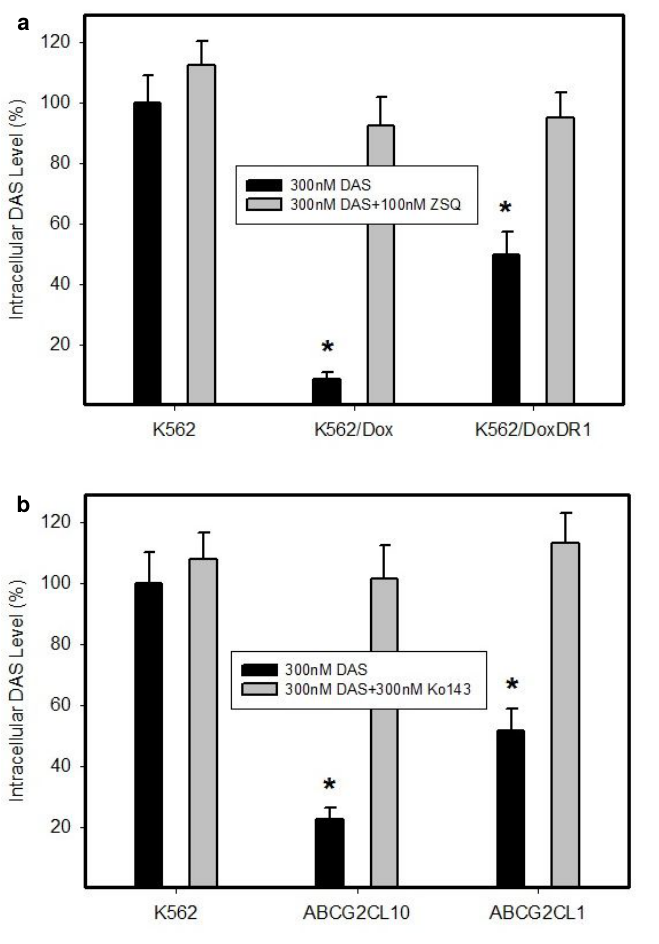
Figure 2. Intracellular levels of DAS in cells expressing ABCB1 or ABCG2. Parental cell line K562, which does not express any of transporter was used as a control. Cells were incubated with 300nM DAS or with 300nM DAS + appropriate inhibitor (100nM ZSQ or 300nM Ko143), as indicated. Intracellular level of DAS was determined after 3h incubation at 37°C. The experimental points represent mean values from three replicate experiments, with standard deviations. a : A relative intracellular levels of DAS in cells overexpressing ABCB1 transporter. * denotes signi fi cant change in intracellular level of DAS (P<0.05) between K562 cells and cells expressing various levels of ABCB1, K562/Dox and K562/DoxDR1. b : A relative intracellular levels of DAS in cells overexpressing ABCG2 transporter. * denotes signi fi cant change in intracellular level of DAS (P<0.05) between K562 cells and cells expressing various levels of ABCG2, K562/ABCG2CL10 and